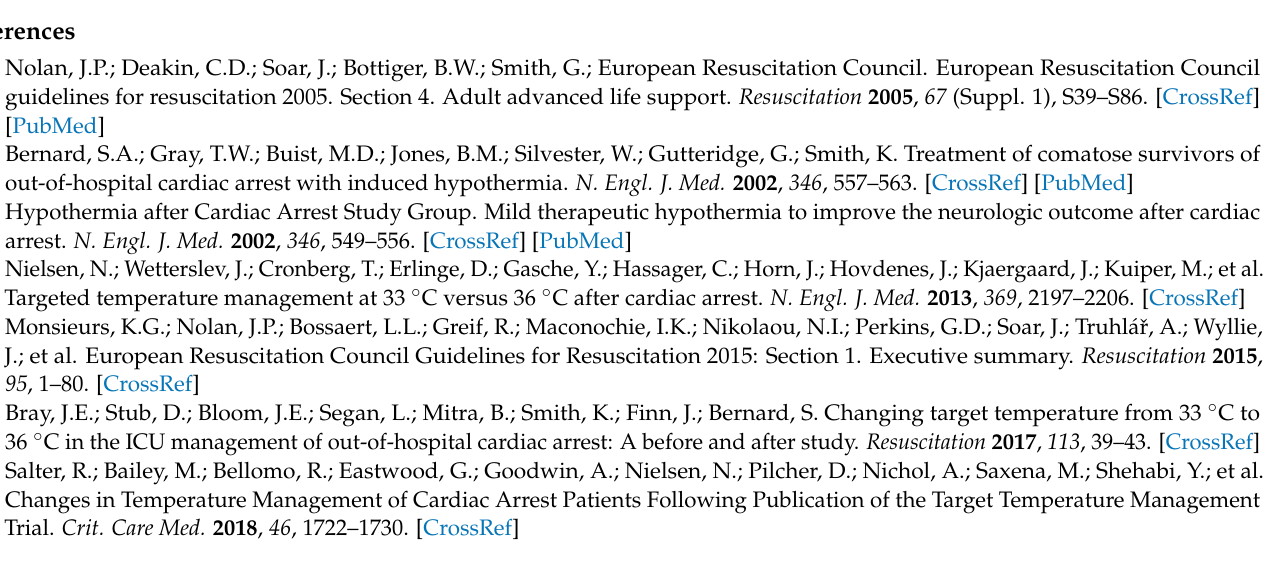
Table S3: Multivariate analysis 90-days mortality, favorable neurological outcome, CPC score, and ICU length of stay; Table S4: Subgroup analysis in patients with lowest temperature available, 90-days mortality, favorable neurological outcome, CPC score and ICU length of stay; Table S5: Subgroup analysis lowest temperature reached during TTM, 90-days mortality, favorable neurological outcome, CPC score, and ICU length of